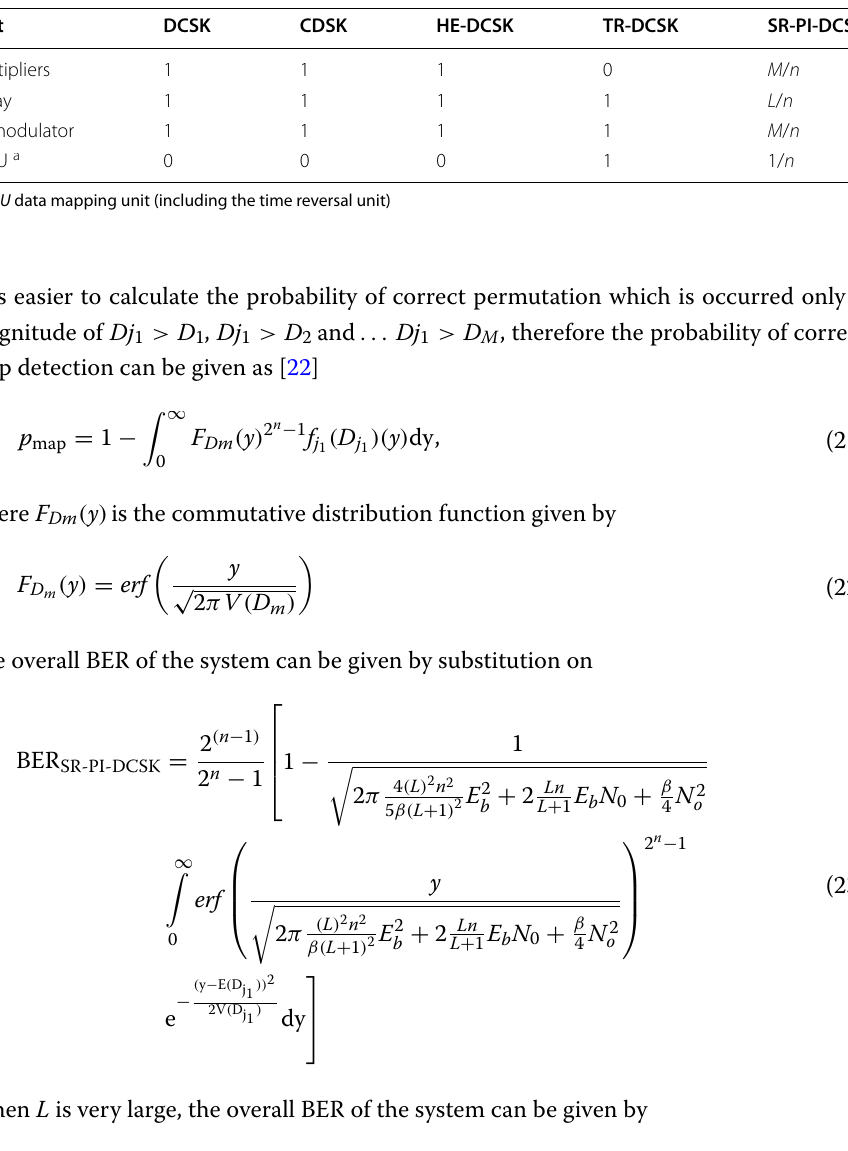
a DPU data permutation unit (including the time reversal unit)